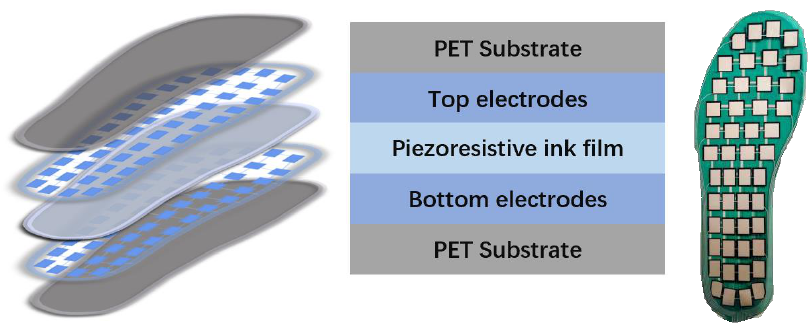
Figure 5. Structure and product of insole system proposed by Zhao et al. [11]. Sensing film is placed in the middle, while sensors are placed on the upper and lower film surfaces. Sensors are different sizes in different positions.